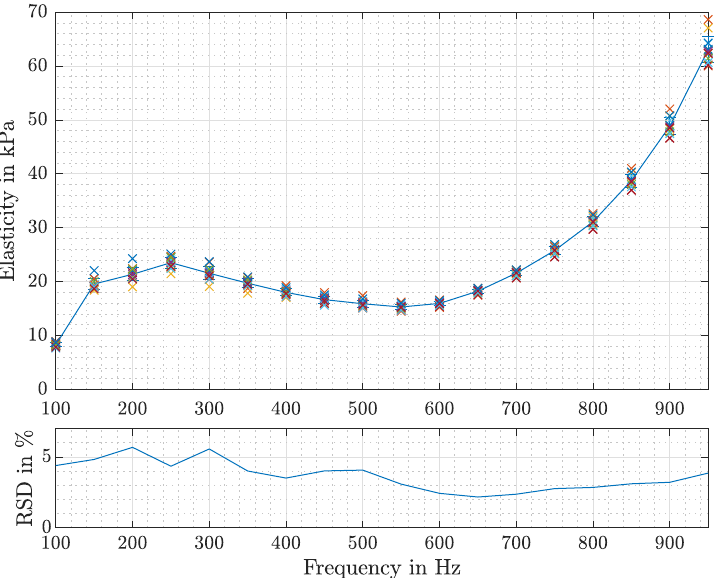
Figure 8. The measured elasticity values for each frequency are marked with crosses. The mean value is plotted with the solid line. Beneath, the relative standard deviation (RSD) is shown in